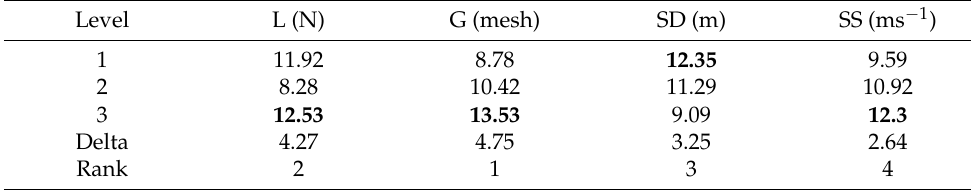
Table 6. Response table for SNRs of µ (smaller is